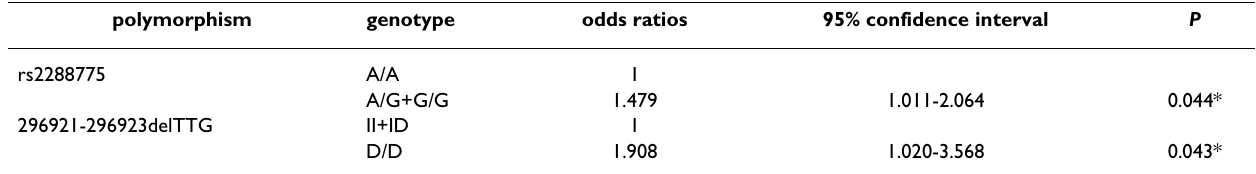
Table 4: Odds ratios and 95% confidence intervals for two variations of NEDD4L gene associated with essential hypertension in female after adjusting smoking, drinking, age and obesity polymorphism